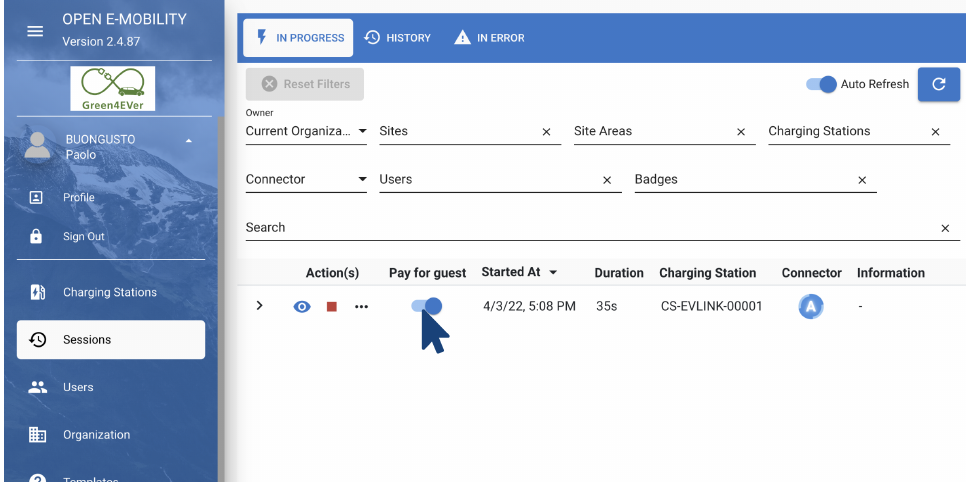
Figure 6. Example screenshot to initiate the transfer of costs of charging in the